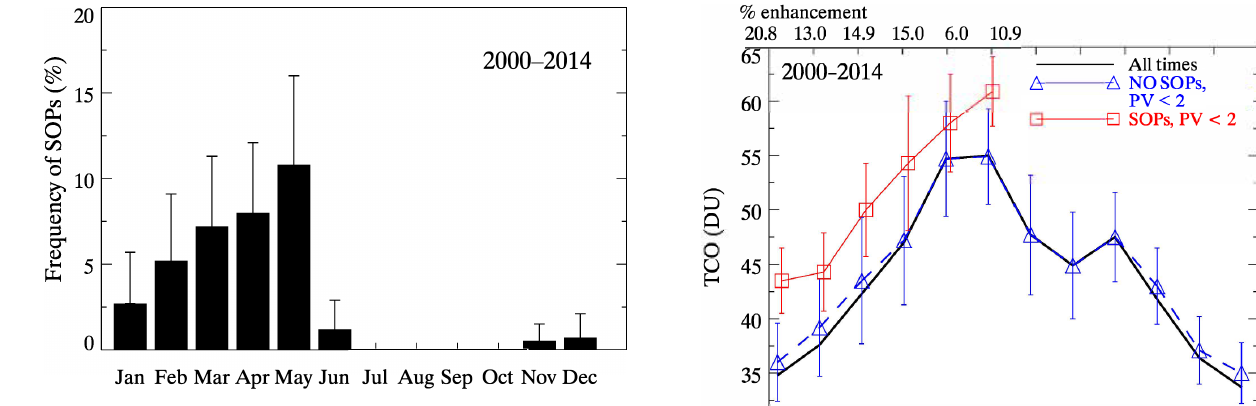
Figure 11. Annual cycle of SOP occurrence frequency (%) over Nainital, calculated from the EMAC simulations for the period 2000–2014. The error bars show the standard deviation of SOP fre- quency during each month among different years 2000–2014 pe- riod.